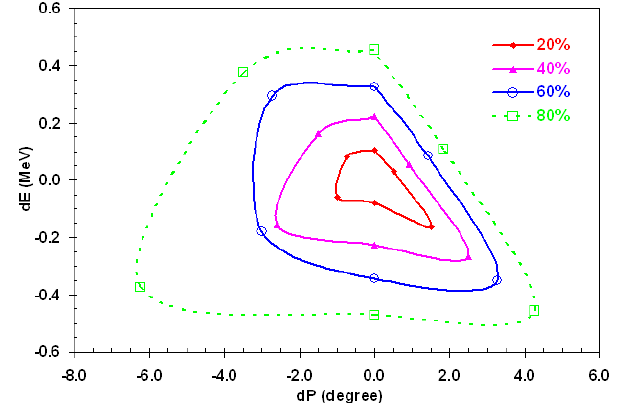
FIG. 13. (Color) One of the measured beam longitudinal emit- tance contours at the second SCL cavity, beam rms emittance is approximately 2 : 7 deg MeV , or twice that of the nominal de-